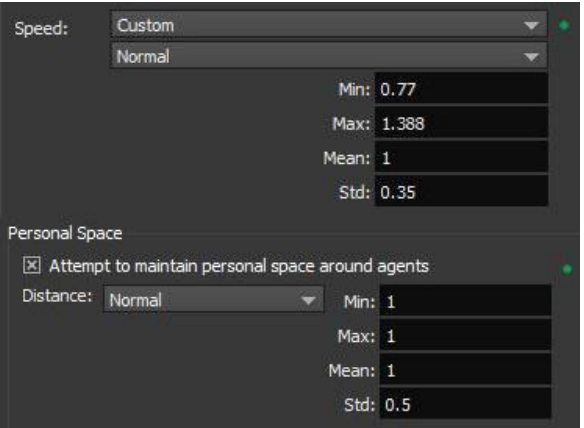
Figure 8. Profile settings used in flow simulations in MassMotion. The speed of a child was considered in m/s while the personal space was imposed by the CTS.